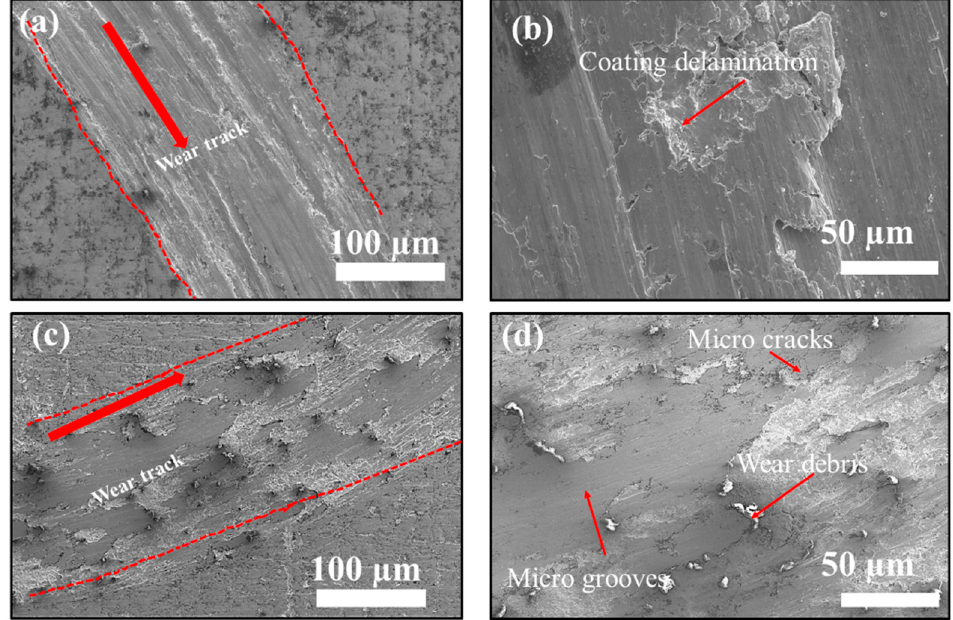
Figure 12. ( a , b ) low ‐ and high ‐ magnification SEM images of the wear track of S2 coating and ( c , d ) low ‐ and high ‐ magnification SEM images of the wear track of FSP ‐ S2 coating .